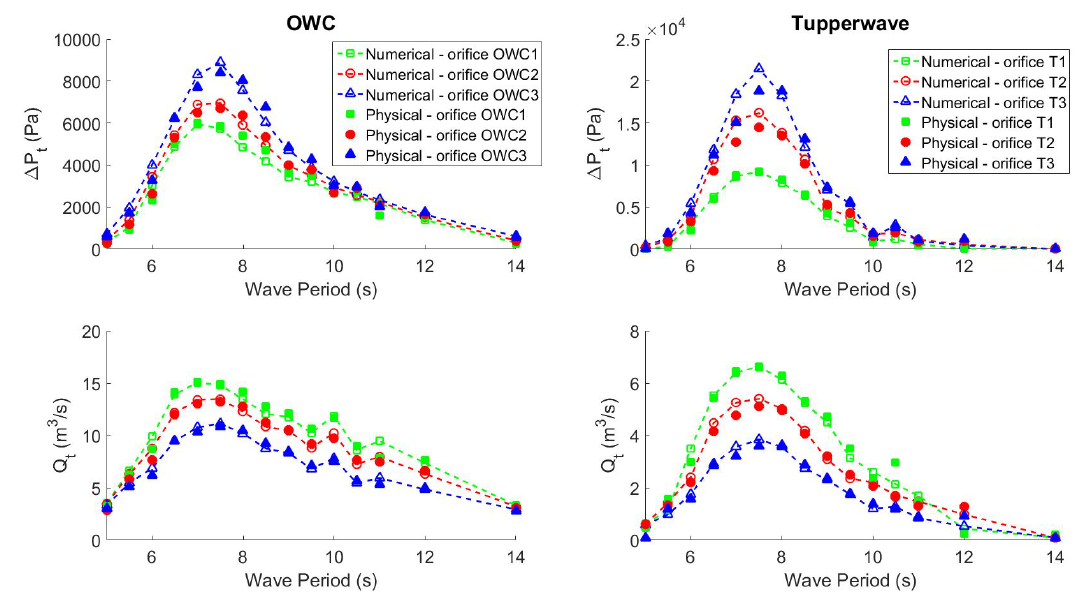
Figure 15. Average pressure drop and volumetric flow rate across the orifice for the conventional OWC and the Tupperwave device in two-meter high regular waves.